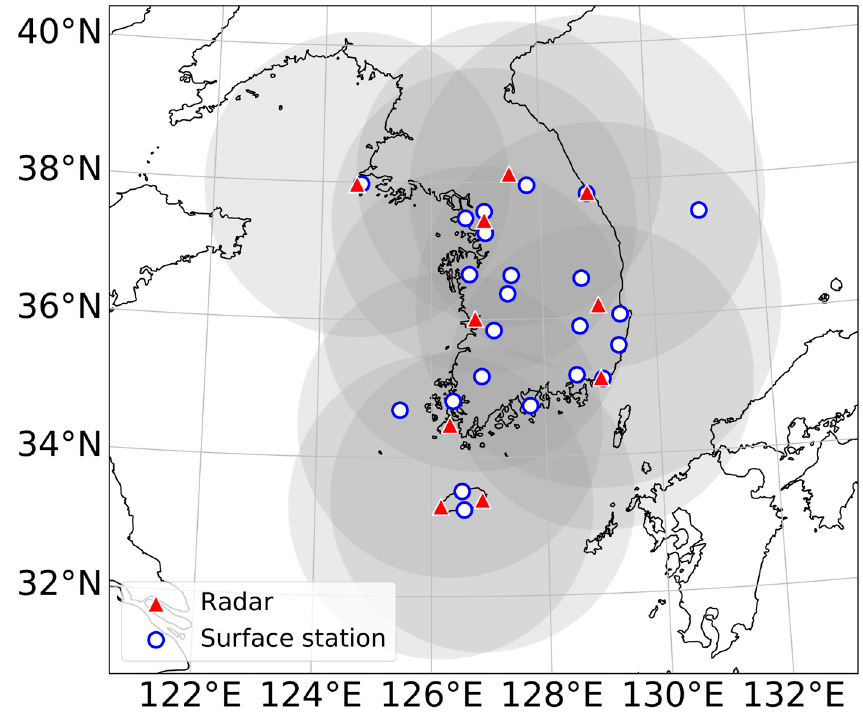
Figure 1. Dual-polarization radar networks (red triangle) with ~240 km range from each radar (gray shading) and surface station for present weather observation (blue open circle).